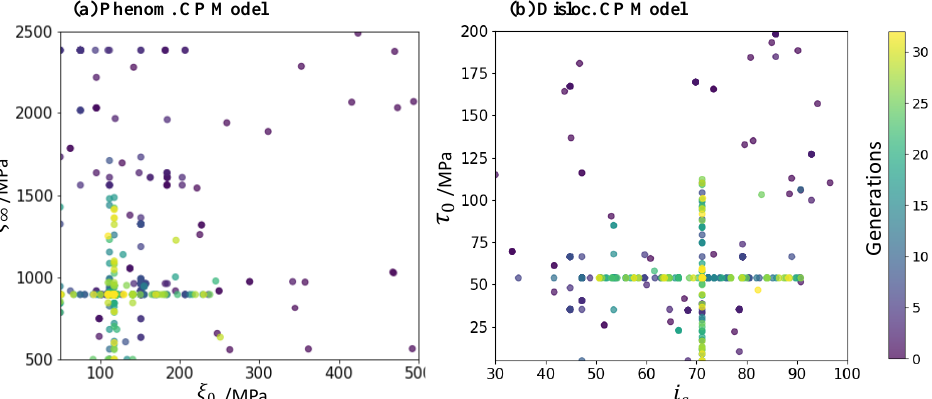
Figure 13. The evolution of the gene corresponding to ( a ) ξ 0 and ξ ∞ in the phenomenological CP model and ( b ) τ 0 and i s in the dislocation-density-based CP model.